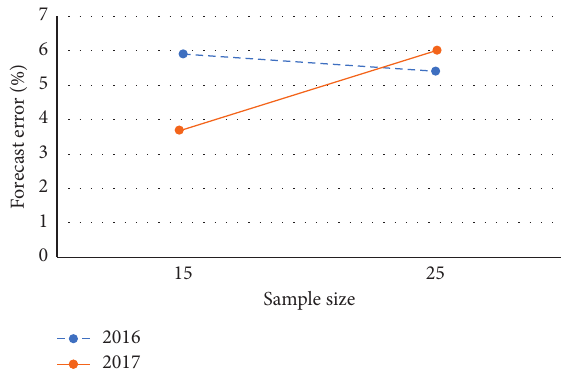
Figure 5: Forecast error for the subject